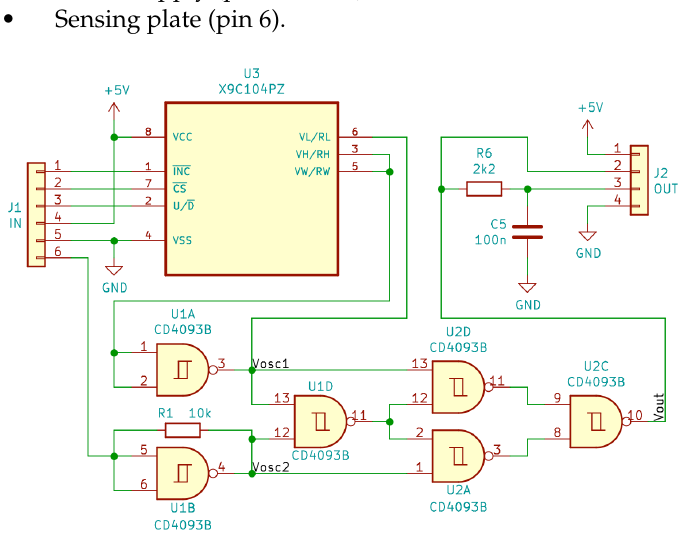
Figure 2. Schematic of the proposed